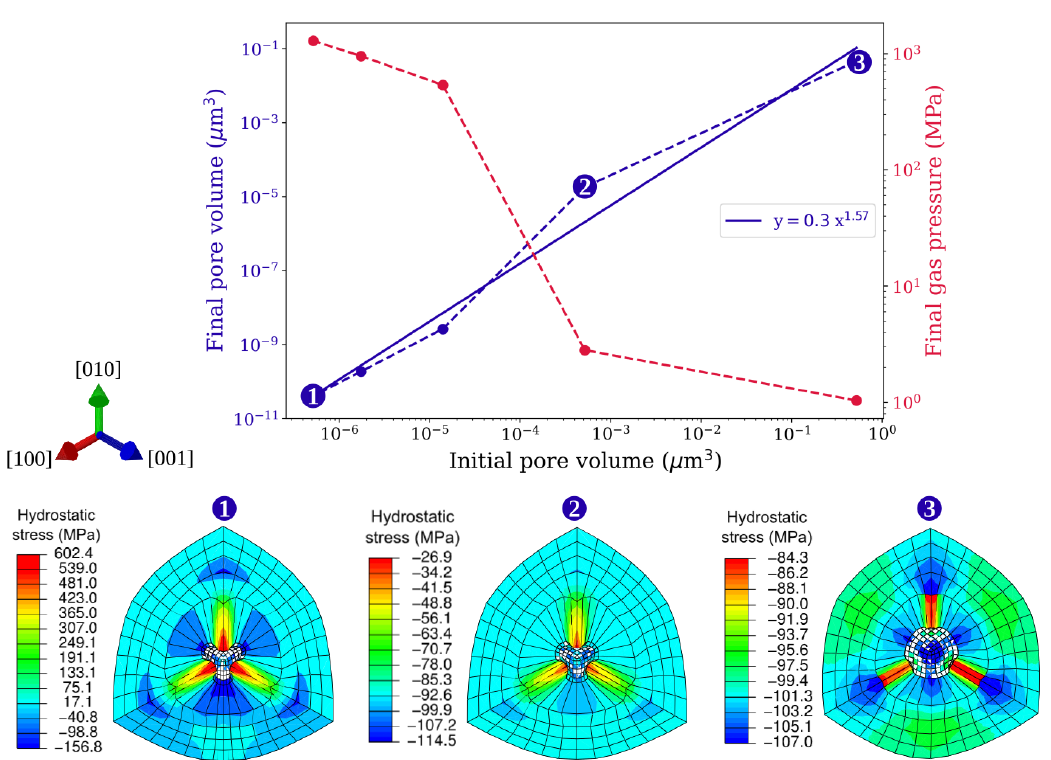
Figure 15. ( Top ) Final pore volume and final gas pressure under HIP loading as a function of initial pore volume. ( Bottom ) Snapshots of hydrostatic stress distribution around pores (zoomed area) taken at the end of simulations. Simulations are done with spherical pores of various radii under 100 MPa isostatic pressure at 1561